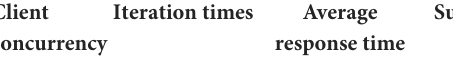
TABLE 3 Resource uploading performance test.